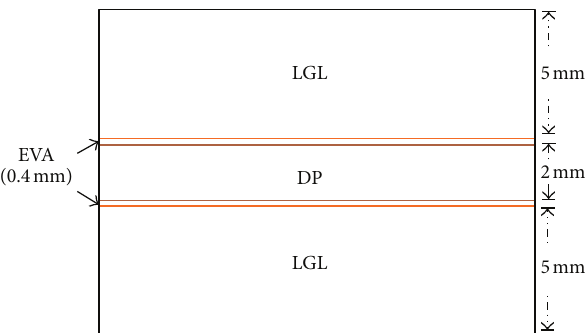
Figure 1: A 1 × 1 feet diffusive solar cell window prototype at work.